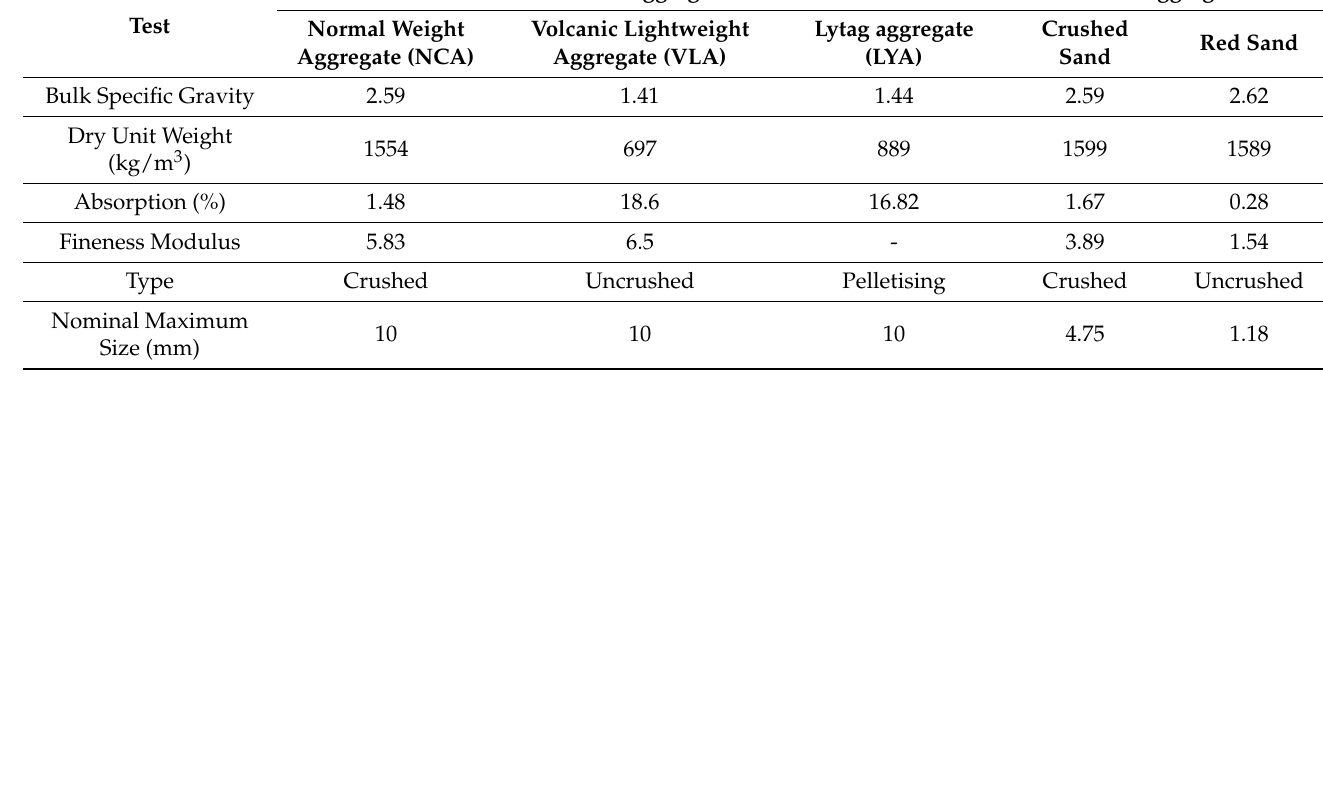
100.0 0.010.020.030.040.050.060.070.080.090.0 Table 1. Properties of different types of aggregate used in the experimental